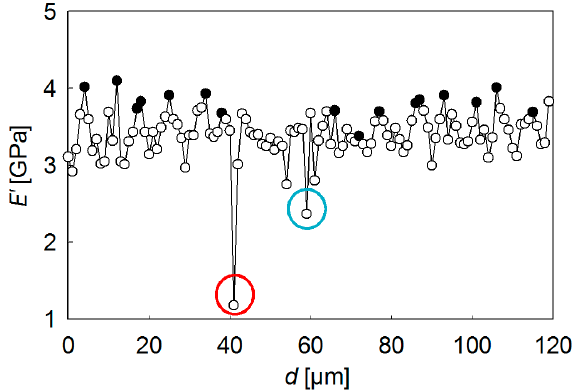
Figure 3. Plot of E ′ (for h = 100 nm) as a function of the distance d to the starting point of the scanning line of Figure 1. Drawn circles denote the location of cracks.